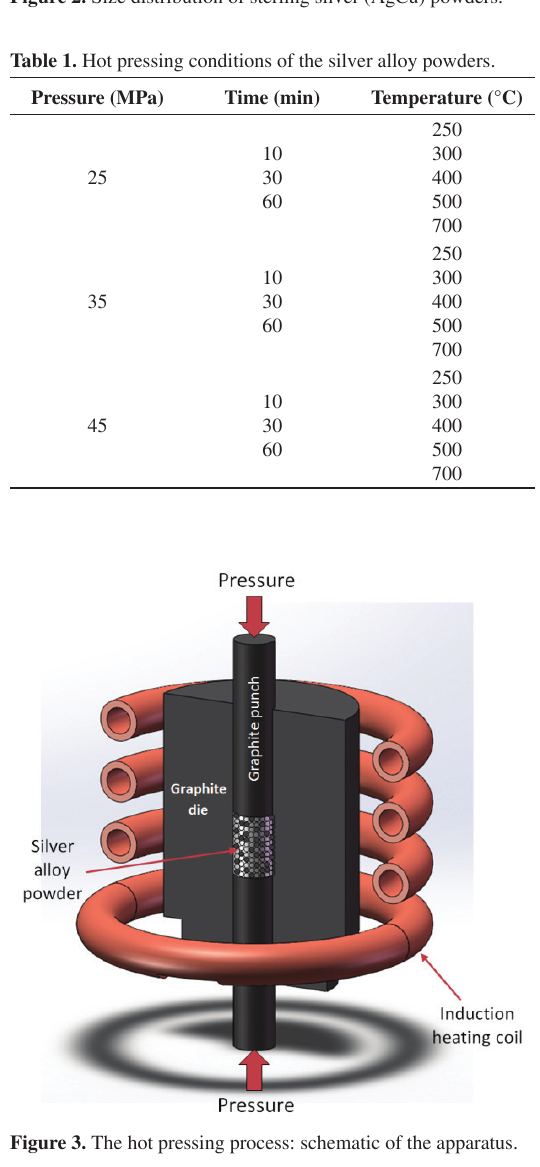
Figure 2. Size distribution of sterling silver (AgCu) powders.